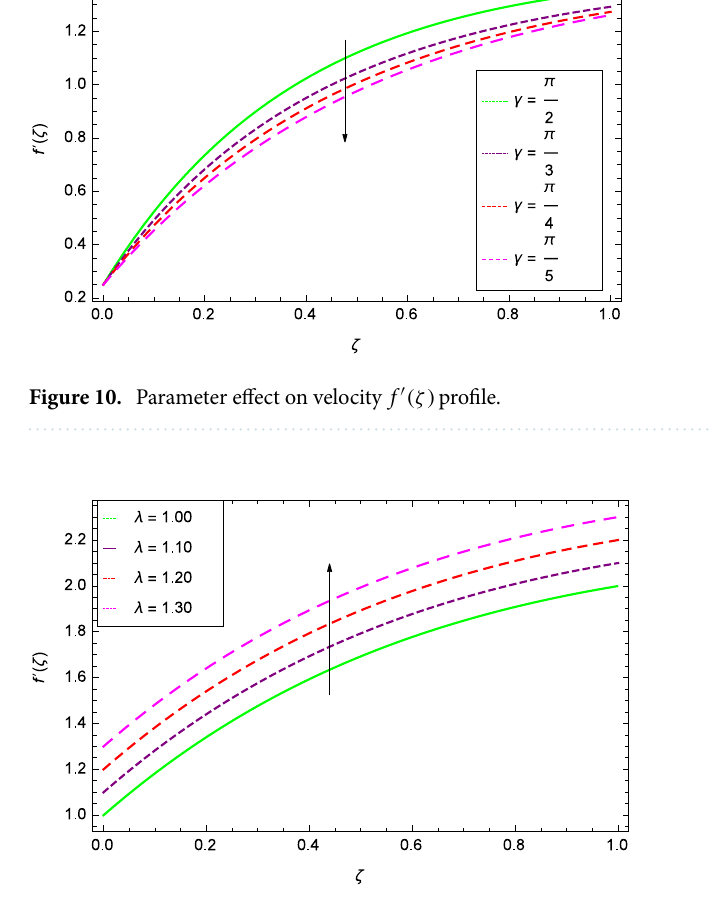
Figure 11. Parameter effect on velocity f ′ (ζ) profile.